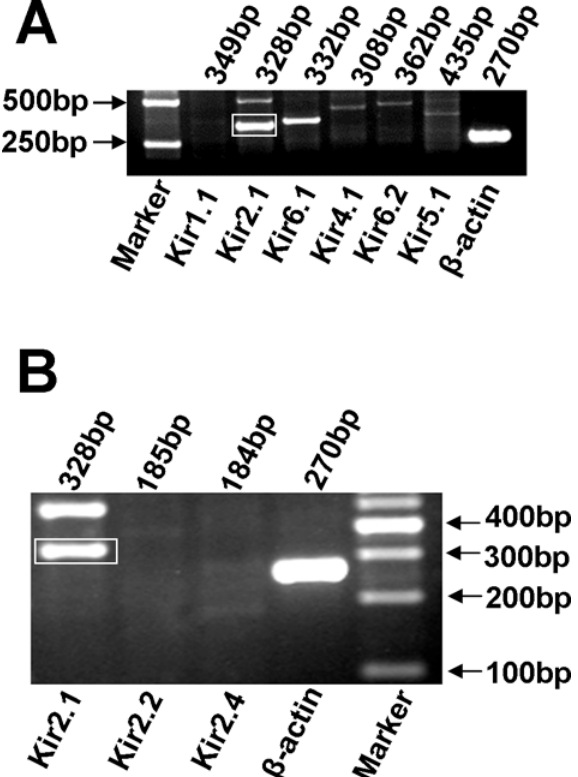
Fig 3. Analysis of mRNA encoding different types of Kir channel subunits. (A) RT-PCR results showed that expression of Kir2.1 was significantly stronger than those of other subtypes (n = 3). (B) The expression of Kir2.1 was more clearer compared with the other Kir 2.x